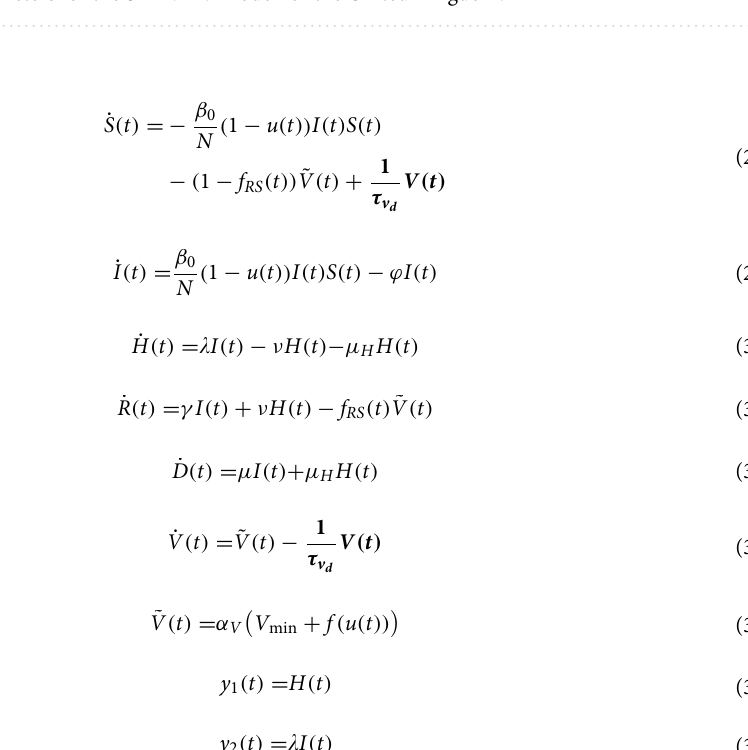
Table 3. Identified parameters for the SIHRD-V model for the United